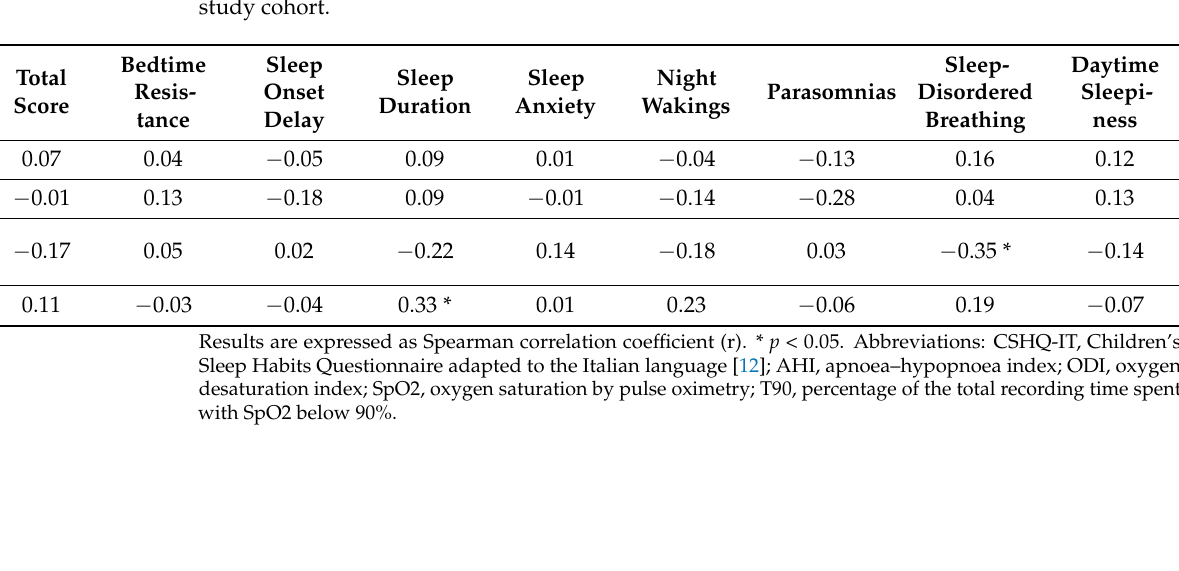
Figure 2. ( a – c ). Oximetry indices from nocturnal polygraphy in children with Down syndrome. ( a ) Each point represents the Oxygen desaturation index (ODI) value in children without OSA (non-OSA), with OSA (OSA), with mild OSA (mild-OSA), and moderate to severe OSA (m/s-OSA). Horizontal bars indicate the median values. The Mann–Whitney test was performed. ( b ) Each point represents the mean oxygen saturation value by pulse oximetry (mean SpO2%) in children without OSA (non-OSA), with OSA (OSA), with mild OSA (mild-OSA), and moderate to severe OSA (m/s-OSA). Horizontal bars indicate the median values. The Mann–Whitney test was performed. ( c ) Each point represents the percentage of the total recording time spent with SpO2 below 90% (T90) in children without OSA (non-OSA), with OSA (OSA), with mild OSA (mild-OSA), and moderate to severe OSA (m/s-OSA). Horizontal bars indicate the median values. The Mann–Whitney test was performed. Table 5. Correlations between overnight polygraphy and CSHQ-IT data in the Down syndrome study